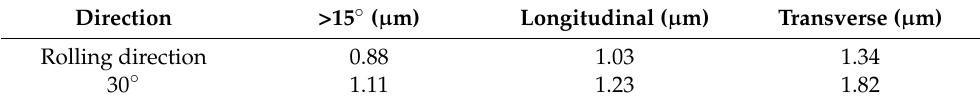
Table 3. Effective grain size of X100 pipeline steel along rolling direction and 30º direction.